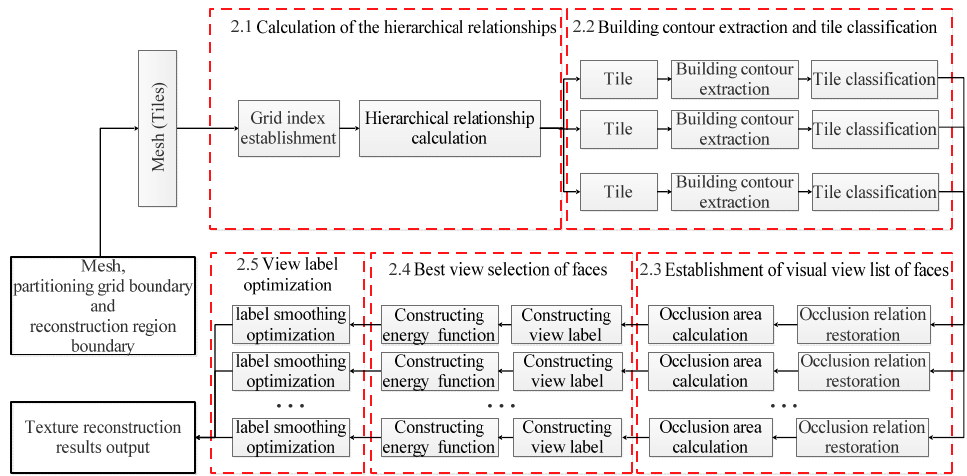
Figure 3. Flowchart of a parallel method for texture construction.